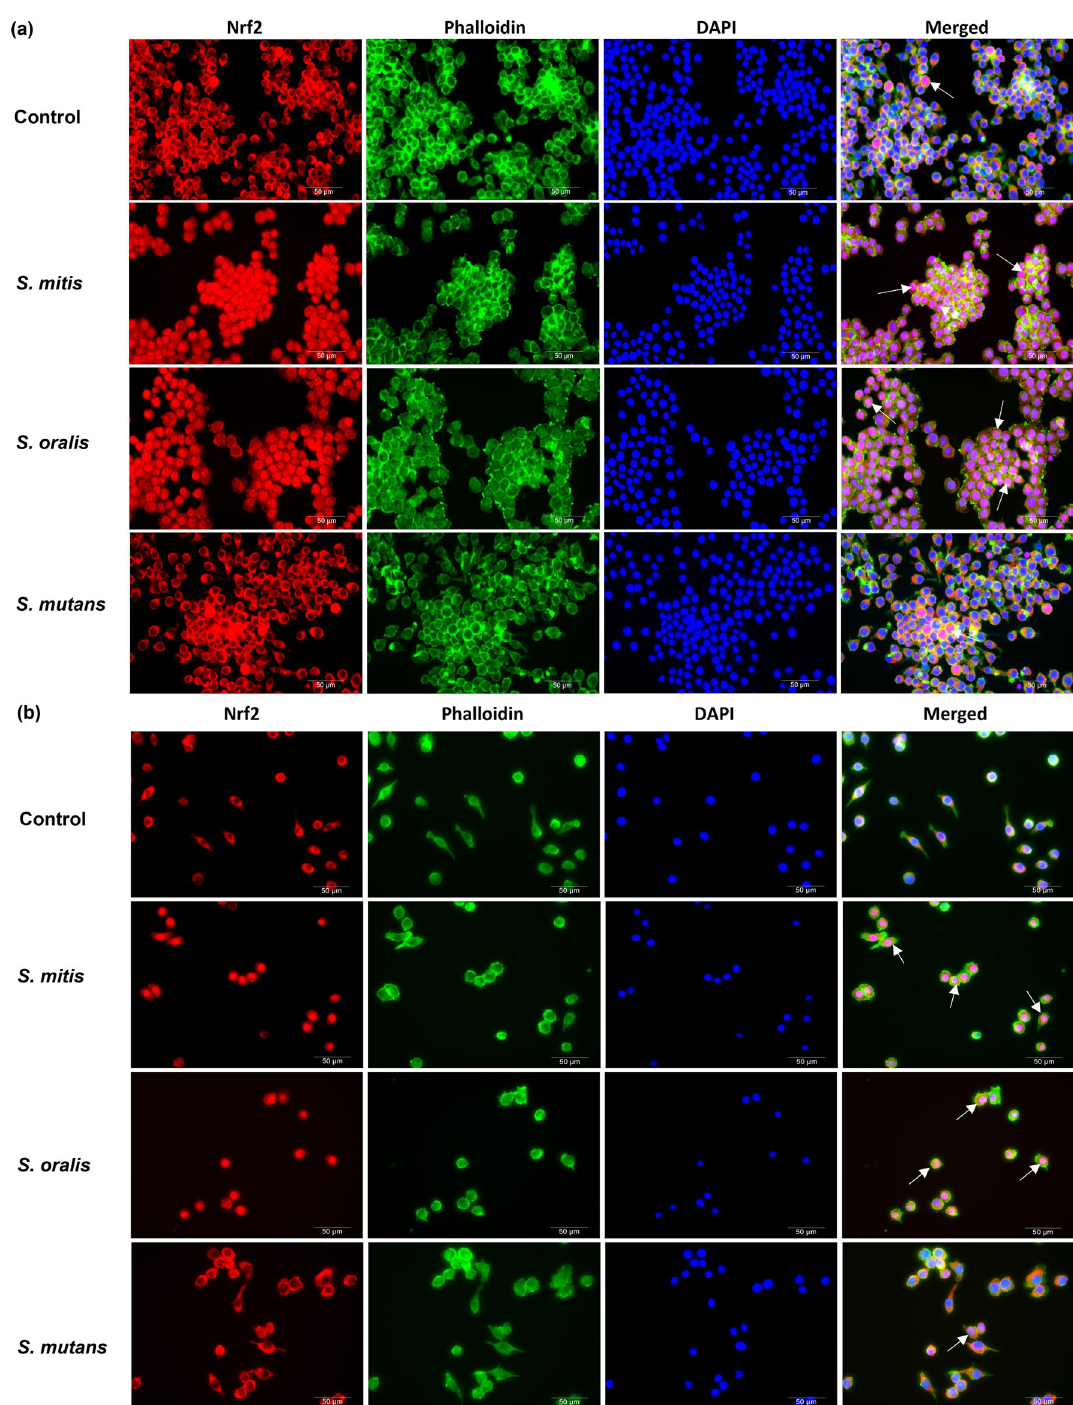
Figure 2. H 2 O 2 producing oral streptococci induced nuclear translocation of Nrf2. ( a ) Raw 264.7 cells and ( b ) BMDMs were infected with the indicated oral streptococci species at MOI 50:1 for 5 h. Cellular localisation of Nrf2 was visualised following staining with anti-Nrf2 antibody (red). Cells were also stained with phalloidin (green), and DAPI (blue) for visualisation of cytoplasm and nuclei respectively. Representative immunofluorescence images are shown at 400× magnification. White arrows indicate nuclear translocated Nrf2. Scale bar: 50